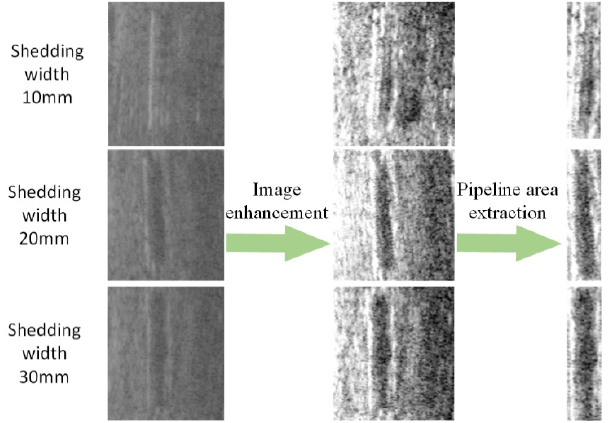
Figure 18. Defect image pipeline area extraction results.